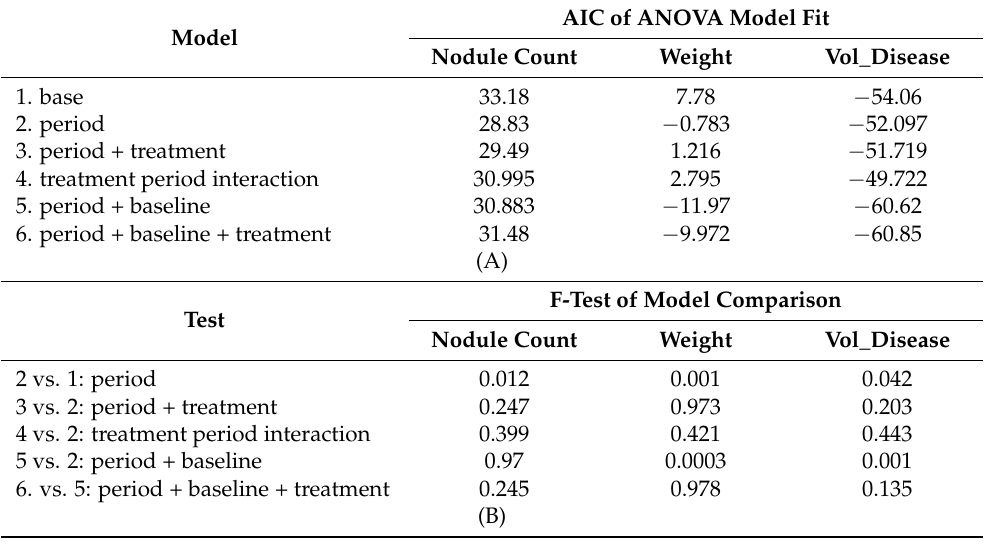
Table 3. (A)—Akaike Information criterion for ANOVA models for study 2. (B)—Likelihood ratio test of ANOVA models of Study 2